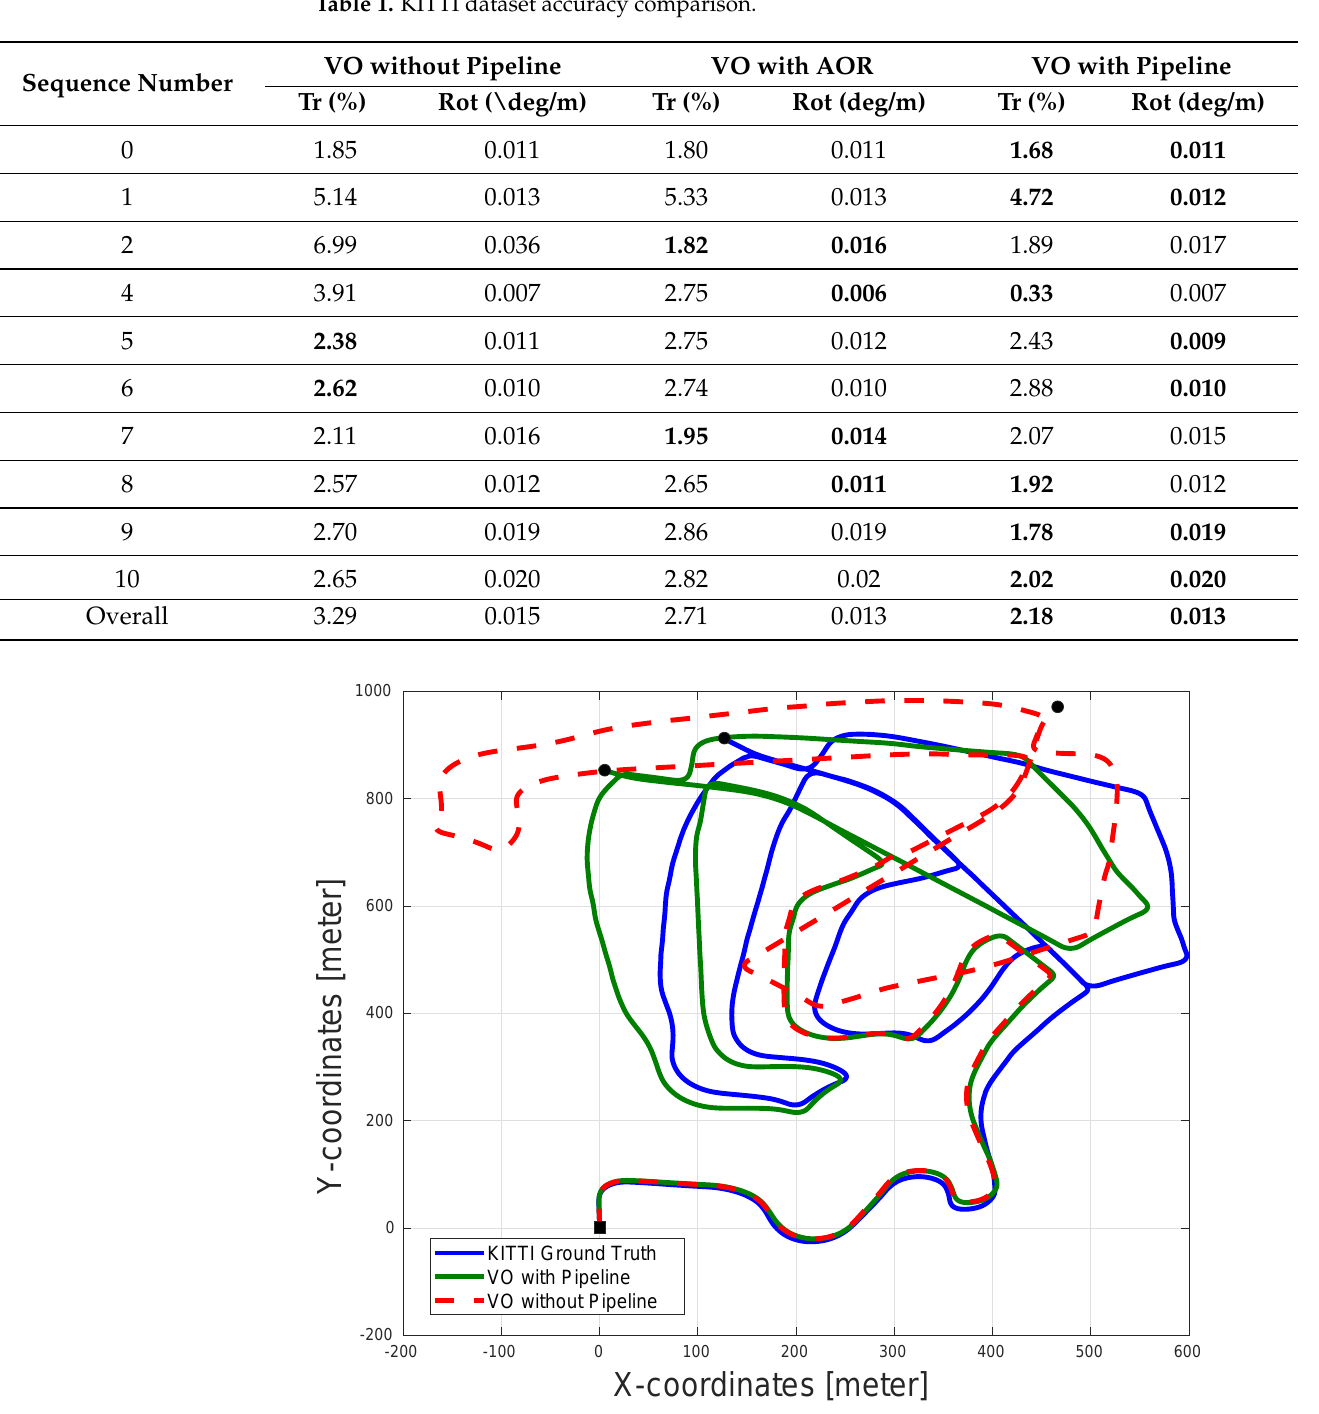
Figure 6. The pose estimation results of sequence 2 in the KITTI dataset with and without pipeline along with the dataset ground-truth. The proposed pipeline significantly enhances the output accuracy of the VO in this sequence. The VO output without the pipeline suffers from major drift errors and can even be considered to diverge. The black square represents the start of the paths and the black circles represent the ends of the